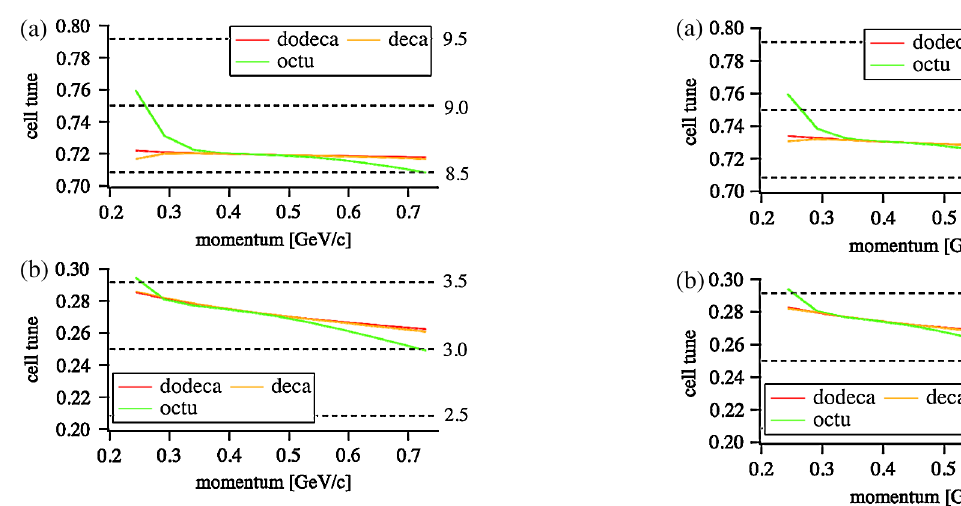
FIG. 8. (Color) Cell tunes throughout acceleration for the case of rectangular-shaped magnets with different order of truncation. Three magnets are aligned parallel with each other. Horizontal cell tune in (a) and vertical cell tune in (b). Dashed lines and associated numbers show total tune of a 12 cell ring.